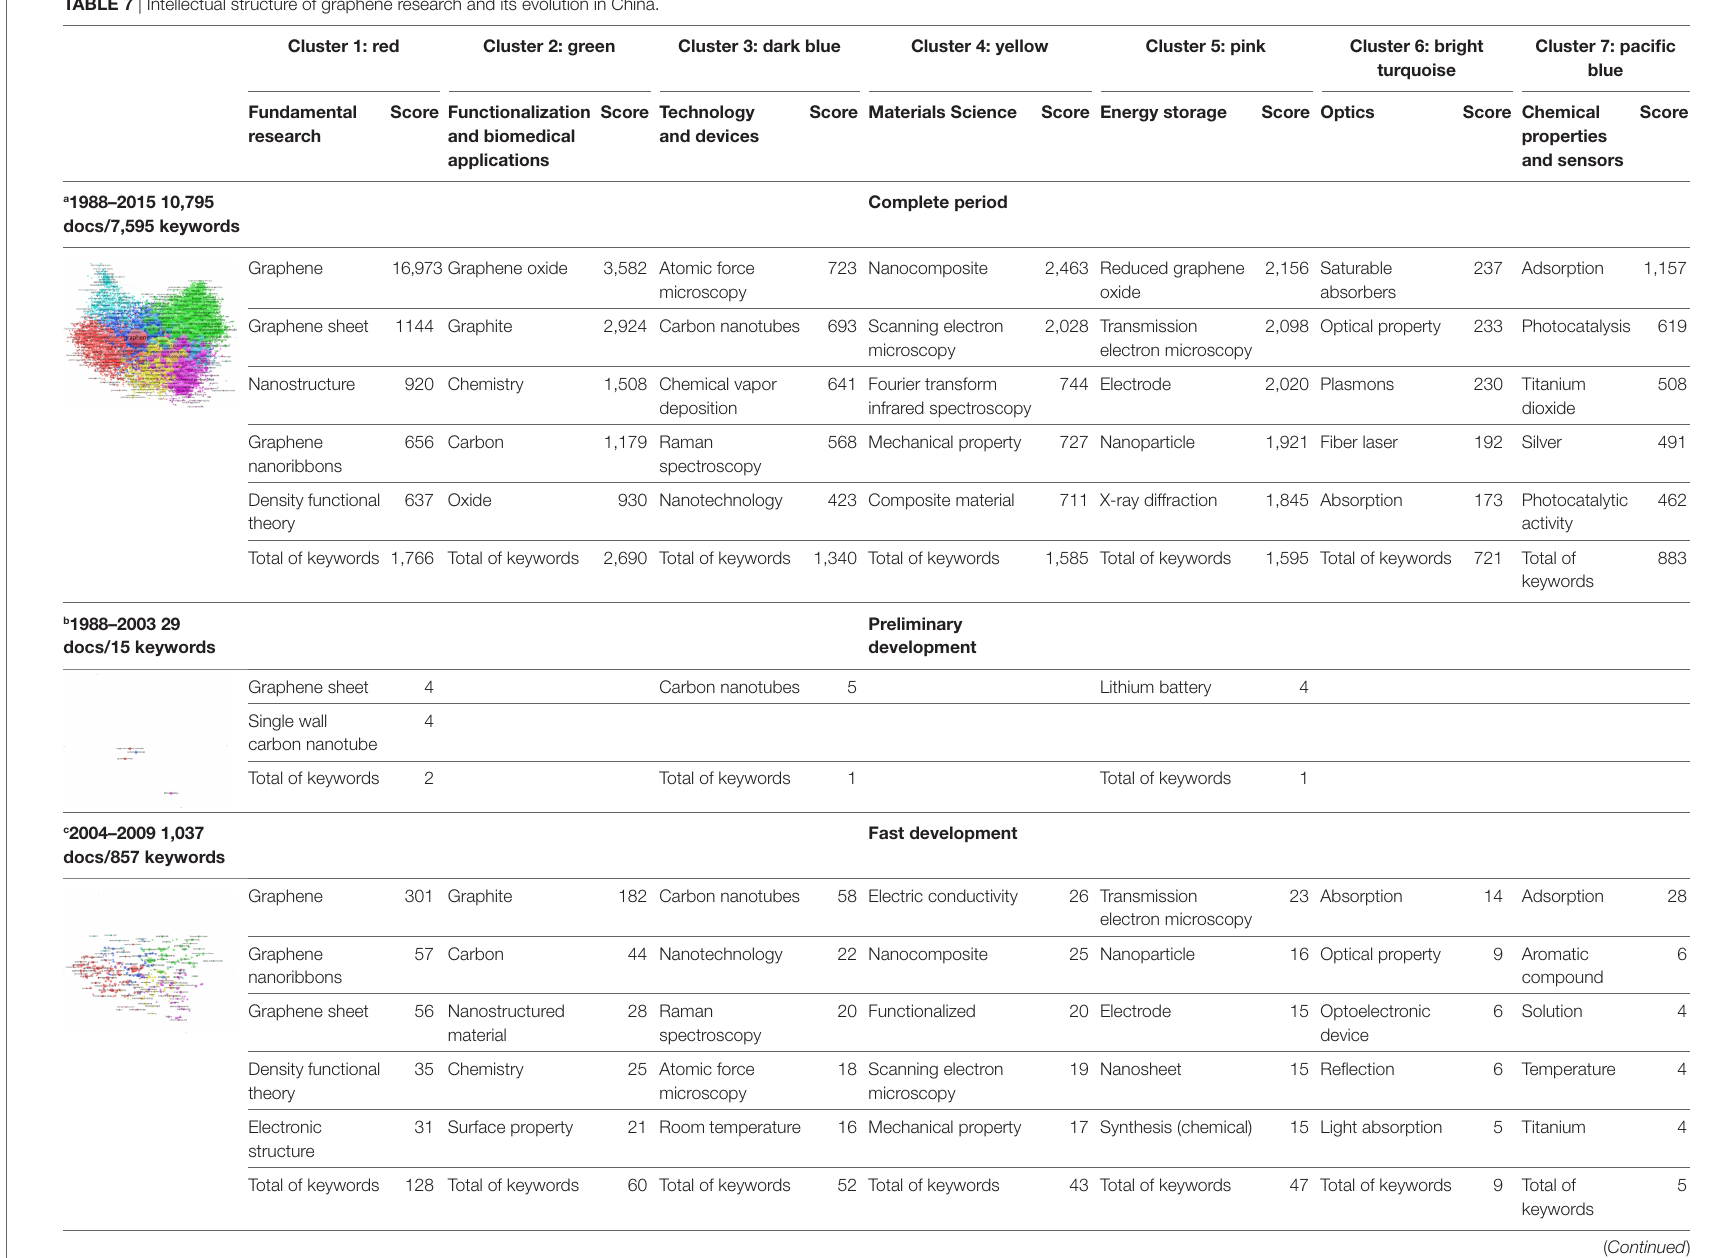
TaBle 7 | Intellectual structure of graphene research and its evolution in